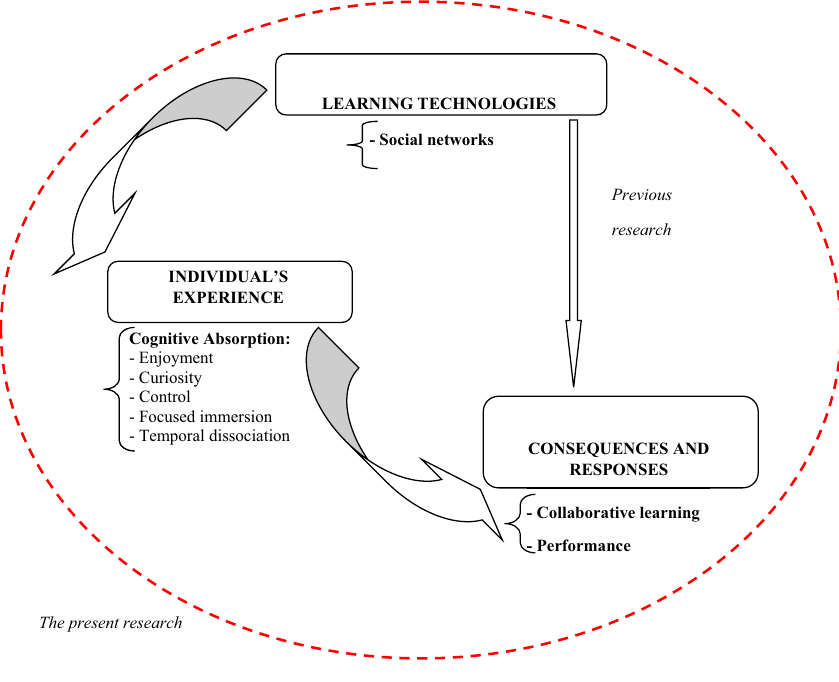
Figure 1. Research focus